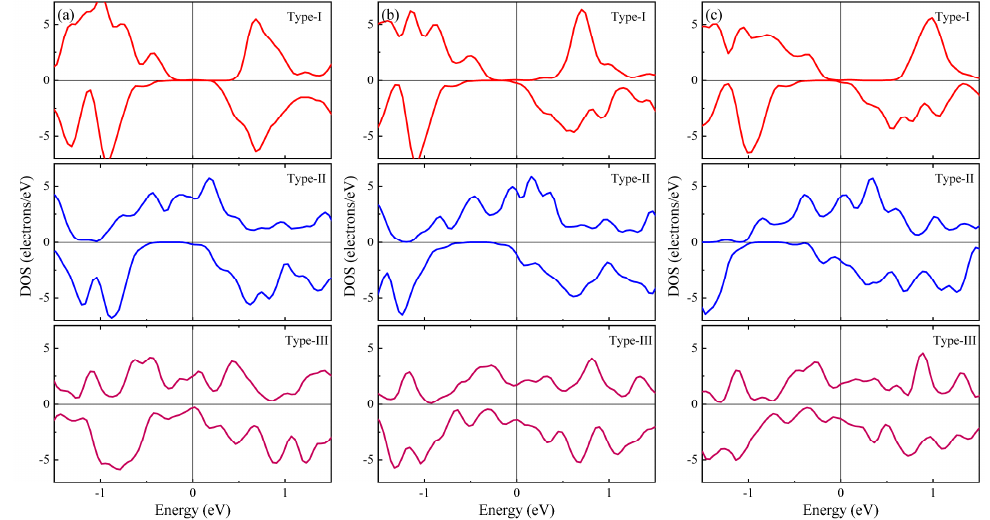
Figure 4. Density of states of the Heusler alloy ( a ) VFeScSb, ( b ) VFeScAs, and ( c ) VFeScP with type-I, -II, and -III